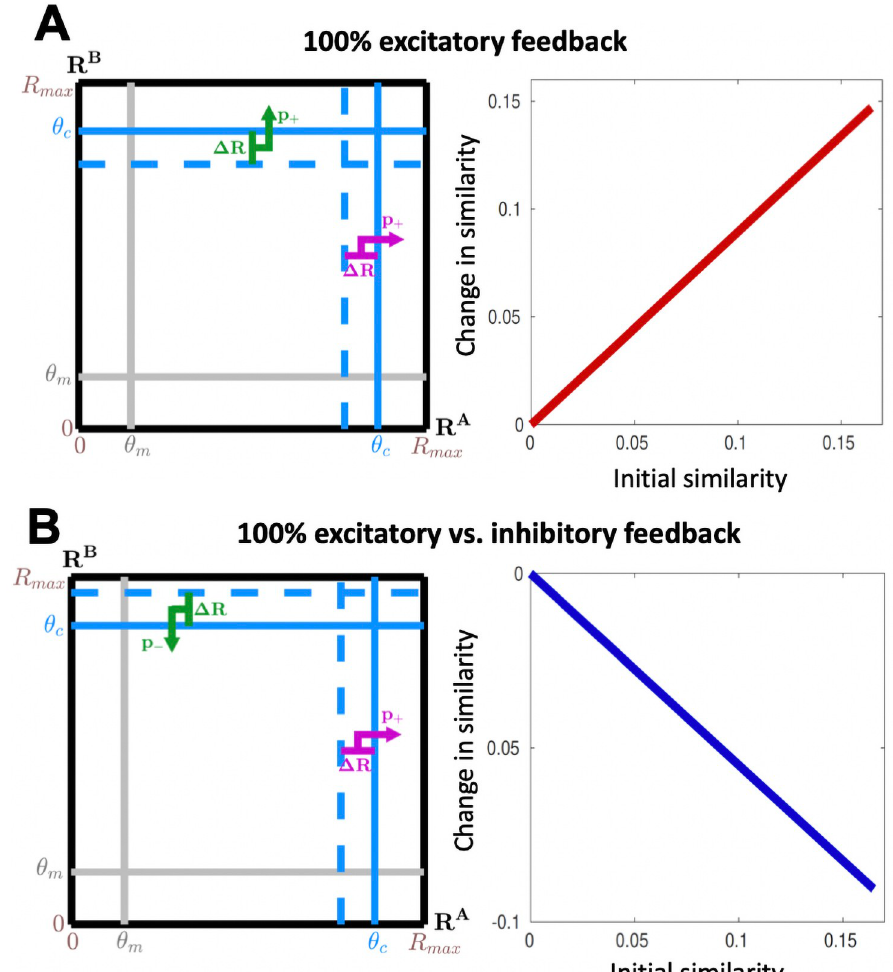
Fig 2. Purely correlated or anticorrelated feedback induces proportionally increasing pattern convergence or divergence, respectively. ( A ) Left: When feedback is identical and positive to all bulb modules for both odors, increasing their responses by Δ R , its effect on the cortical activity is equivalent to a decrease of the cortical activation threshold by Δ R . This results in a positive change in similarity between the cortical odor representations (i.e. pattern convergence). Right: The amplitude of this effect increases linearly with initial odor similarity. ( B ) Left: When the feedback is positive to all bulb modules for odor A and negative for odor B, the change in cortical activity is equivalent to that induced by a decrease/increase of the cortical activation threshold by Δ R for odor A/B respectively. This results in a decrease in similarity between cortical odor representations, i.e. pattern divergence. Right: The amplitude of this effect increases linearly with initial odor